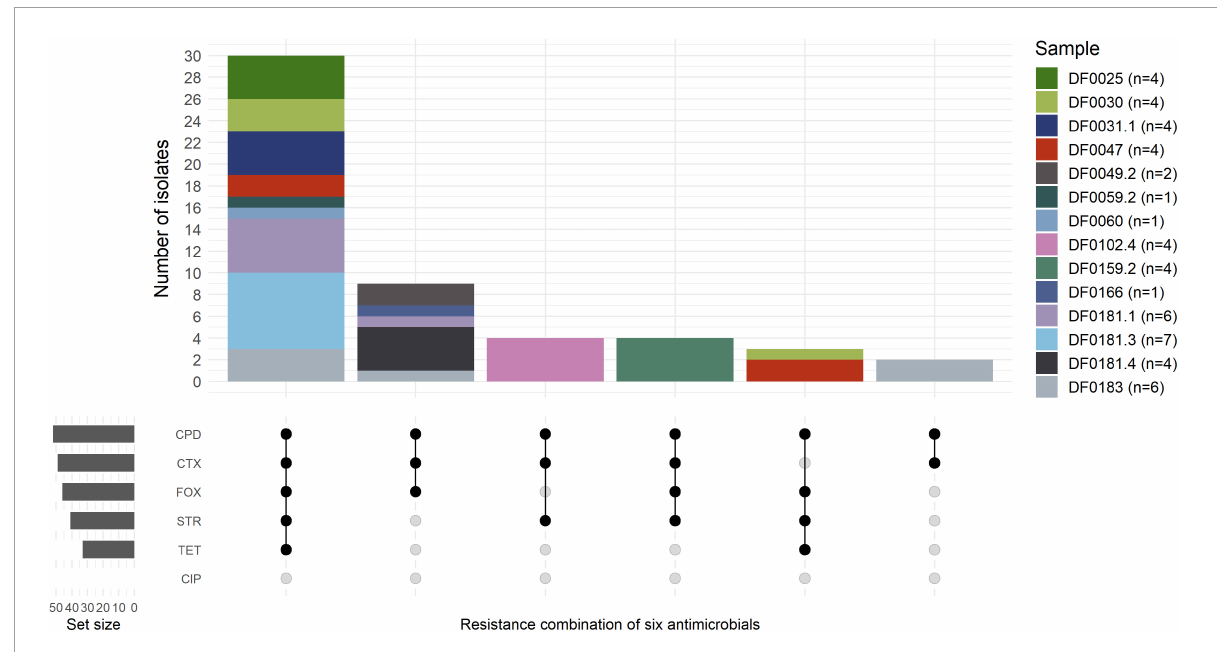
FIGURE1 Resistance profiles of E. coli ( n = 52) isolated across 14 farm samples. The number of isolates per sample is indicated in the brackets. Isolates with intermediate resistance to cefotaxime ( n = 15) were grouped as resistant in the Upset plot. CPD, cefpodoxime (10 µ g); FOX, cefoxitin (30 µ g); STR, streptomycin (10 µ g); CTX, cefotaxime (30 µ g); TET, tetracycline (30 µ g); CIP, ciprofloxacin (5 µ g).